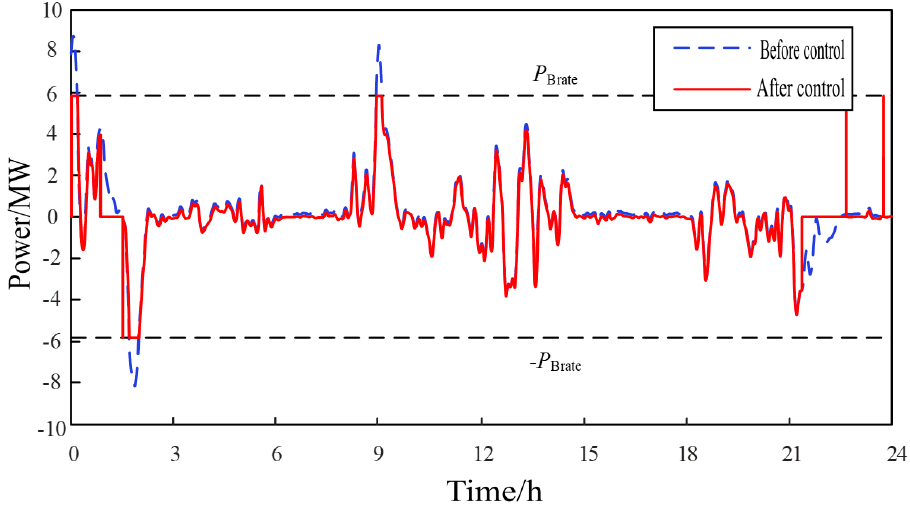
Figure 10. Comparison of battery charge and discharge power curves before and after control.